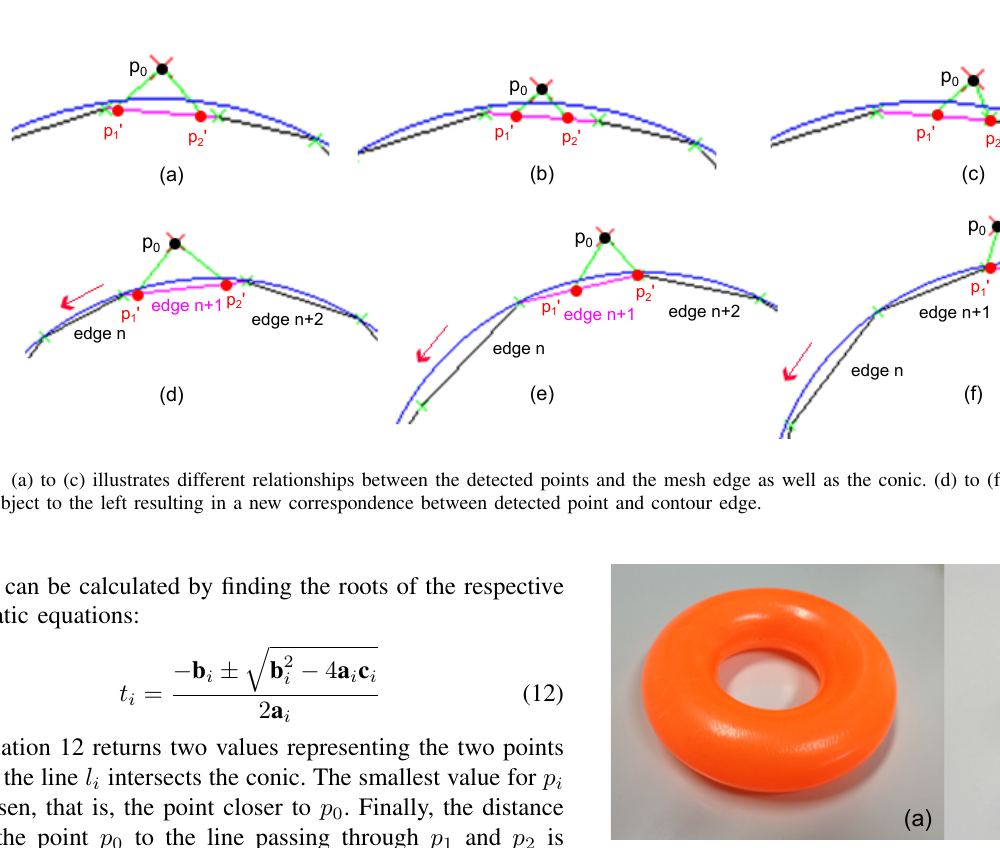
Fig. 10. Example of objects with 5DoF whose accurate pose estimation in one axis is not possible: (a) torus shaped object and (b) a cup without